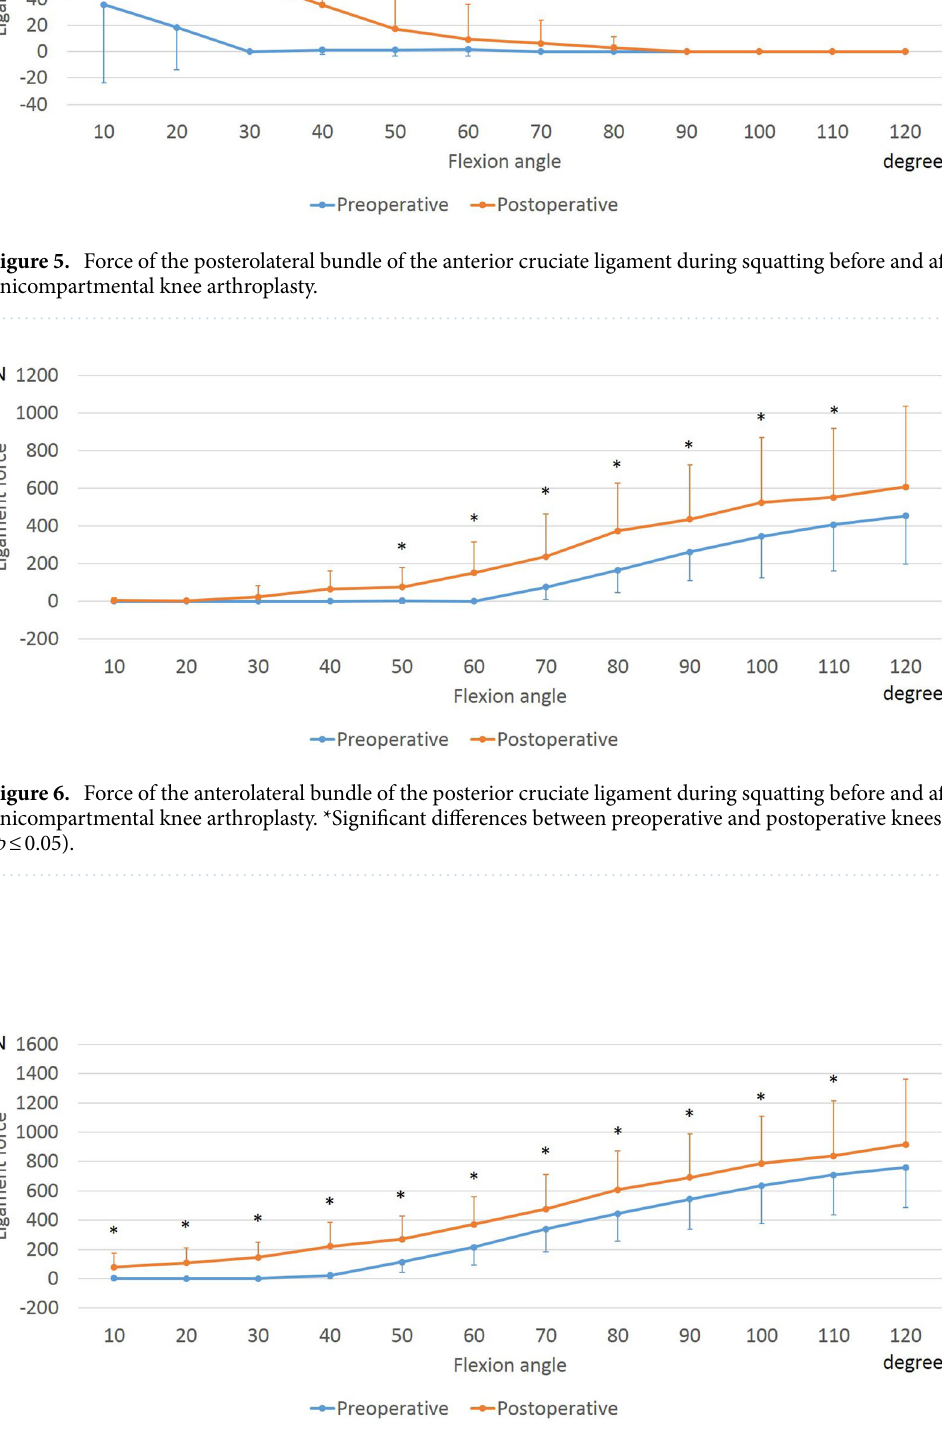
Figure 7. Force of the posteromedial bundle of the posterior cruciate ligament during squatting before and after unicompartmental knee arthroplasty. *Significant differences between preoperative and postoperative knees ( p ≤